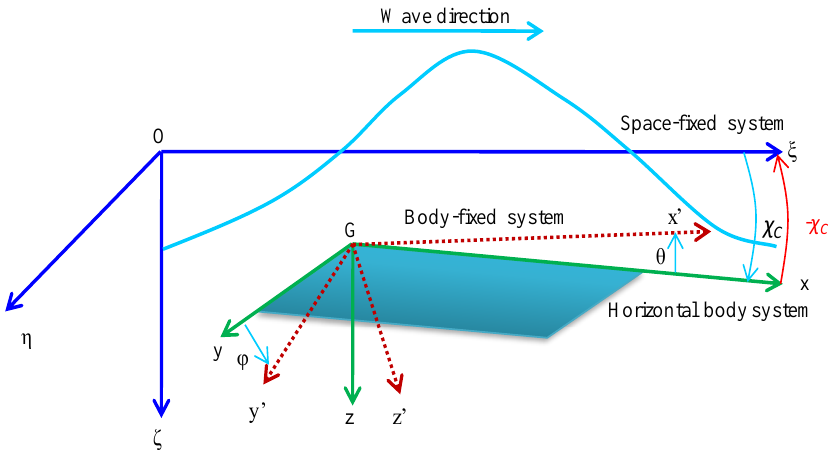
Figure 1. Coordinate systems.